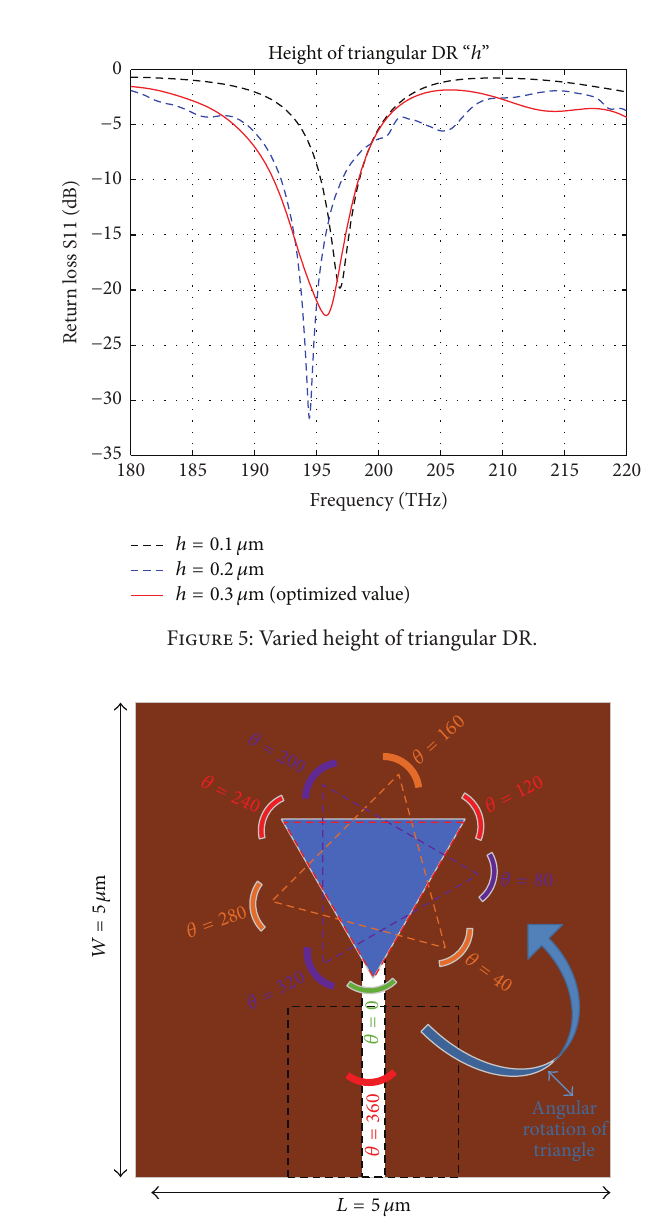
Figure 6: Angular rotation of triangular